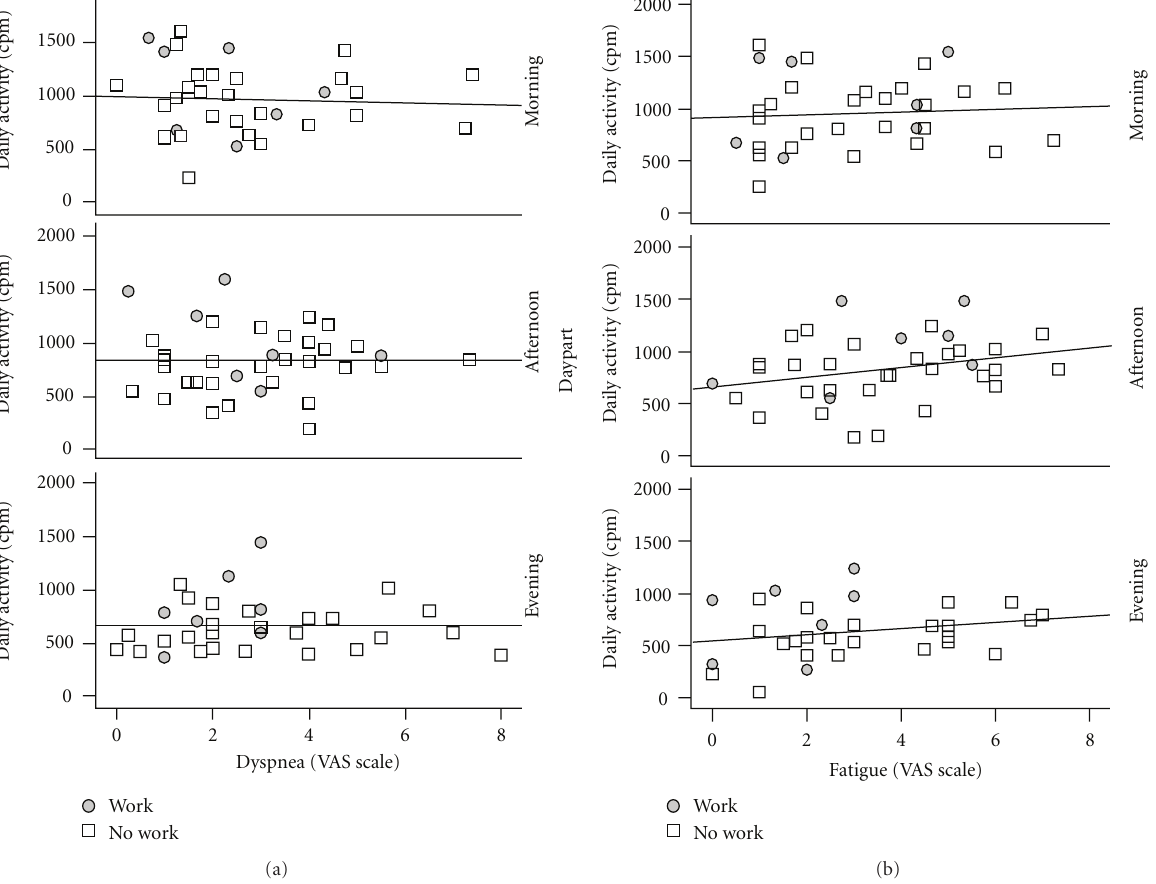
Figure 3: Scatter plots per day part for objectively measured activity (in cpm) ( y -axis) and symptom scores (VAS score, x -axis), with linear trend line. On the left this is shown per day part for dyspnea, on the right for fatigue. Each dot represents the mean of one patient, stratified for